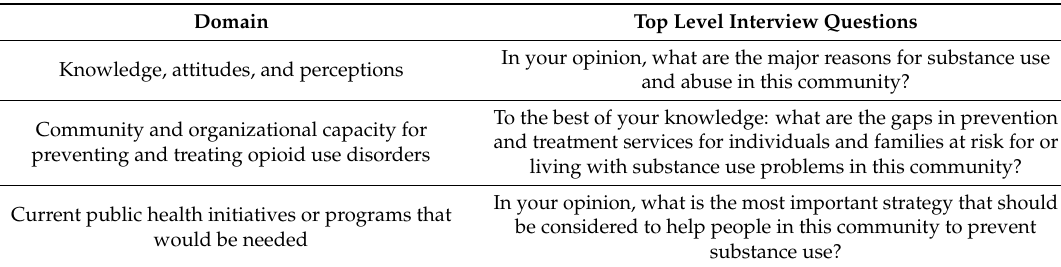
Table 1. Top level questions from the semi-structured interview